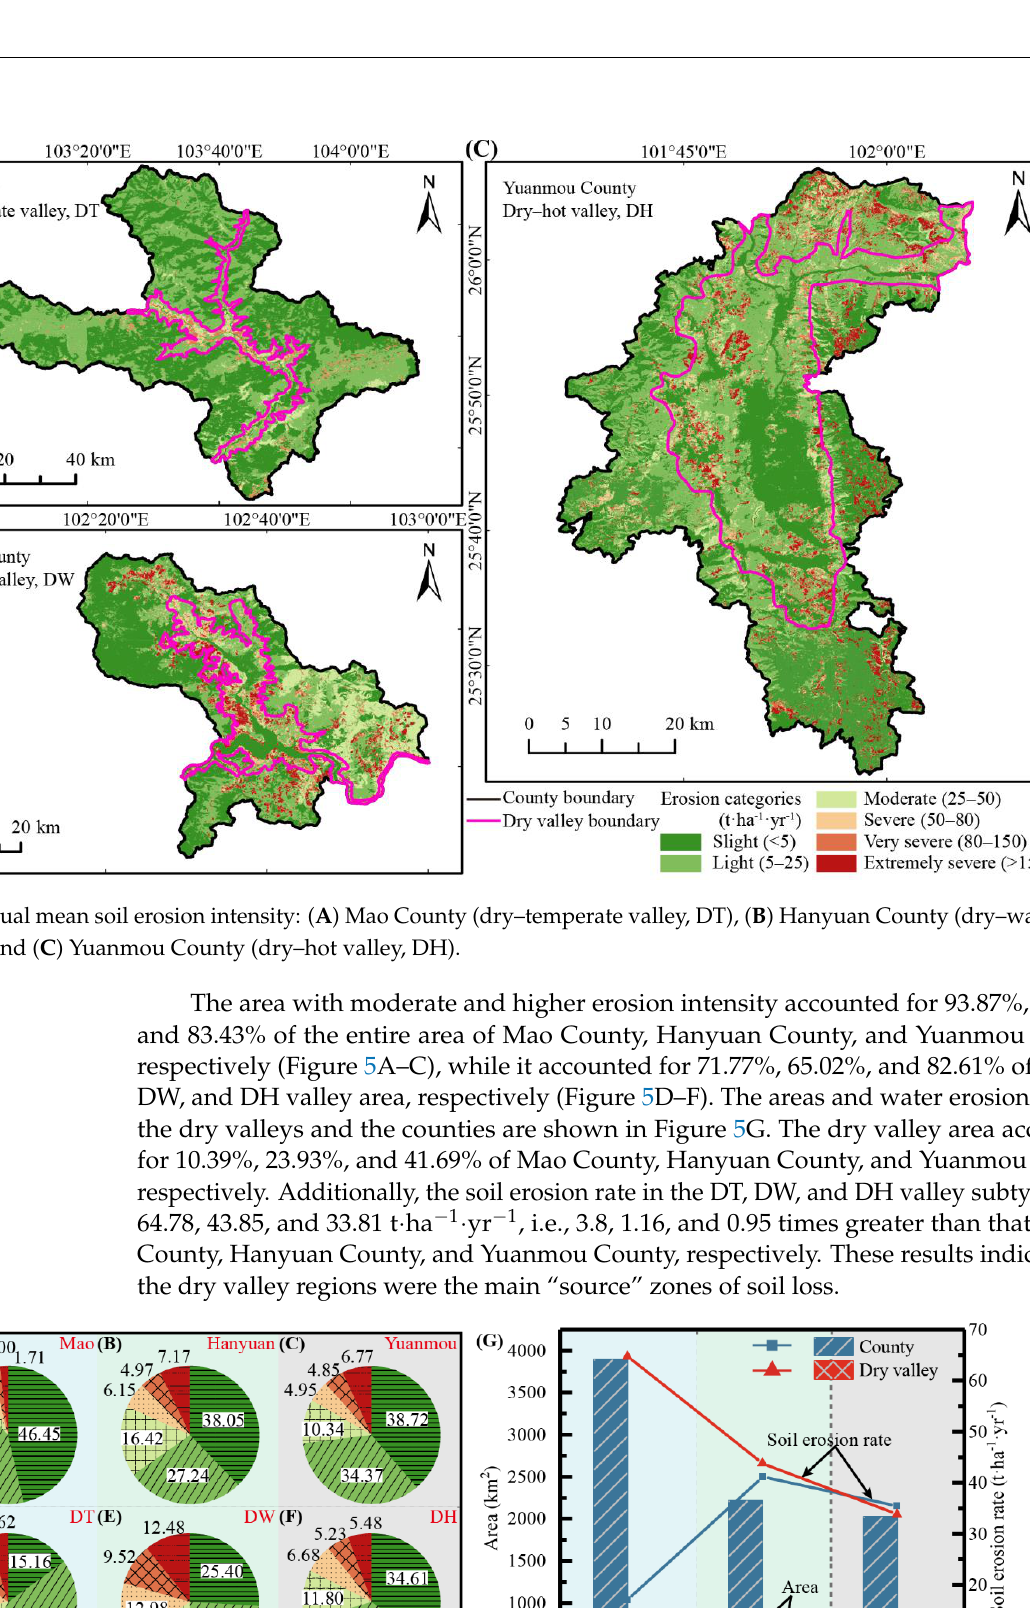
Figure 5. Areas and annual mean soil erosion rates of the three counties and the three dry valley subtypes: ( A – C ) and ( D – F ) area proportions of the three counties and the three dry valley subtypes with different erosion intensity, respectively. ( G ) areas and annual mean water erosion rates of the three counties and the three dry valley subtypes.